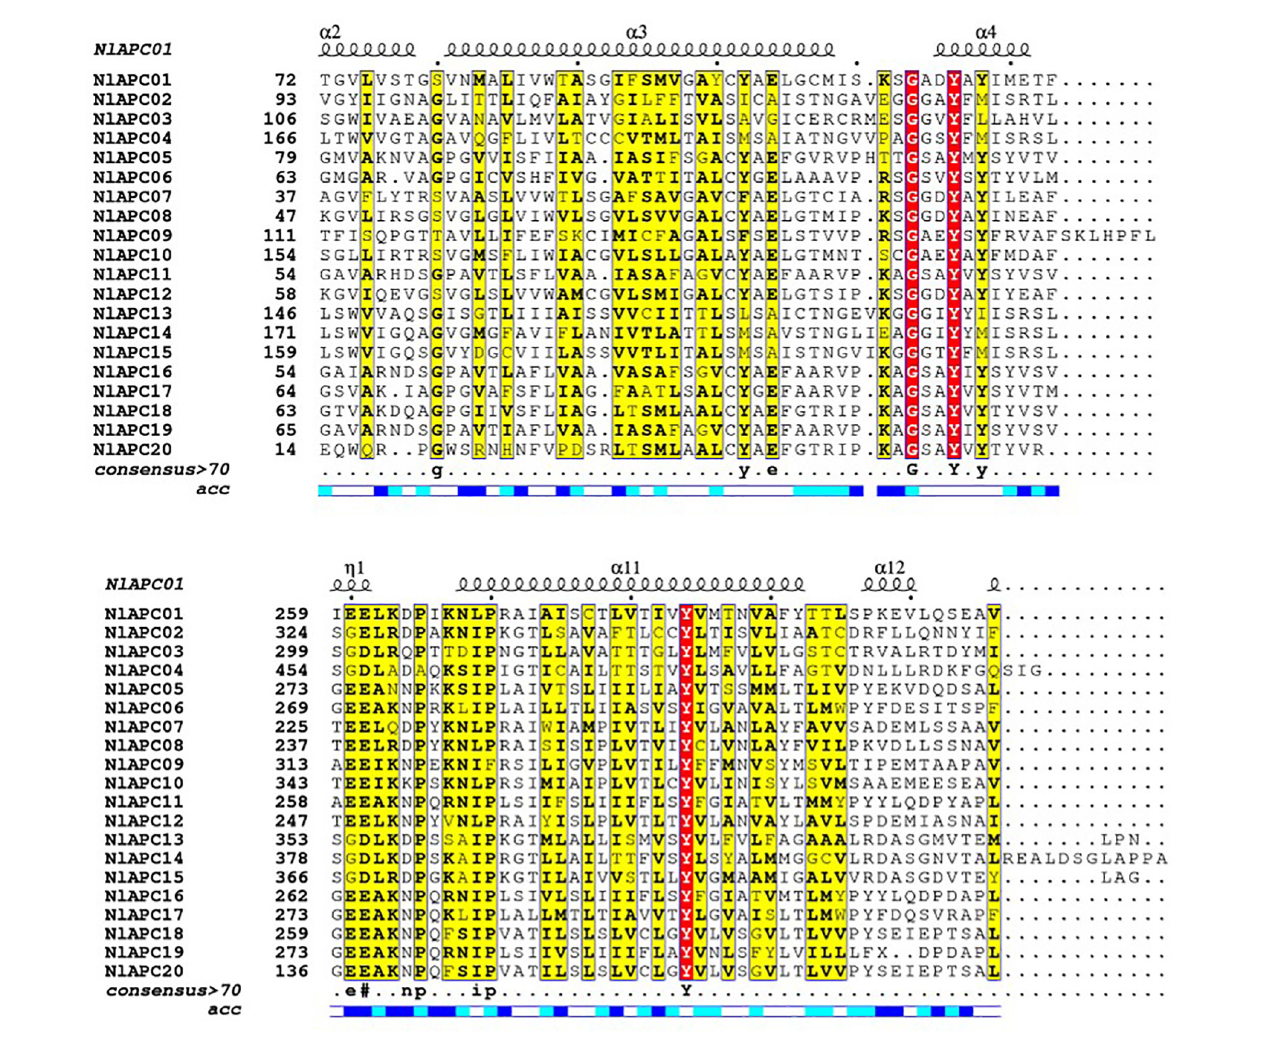
FIGURE 1 | Amino acid sequence alignment and the secondary protein structure prediction for APC transporters from BPH. Amino acid sequences of all 20 BPH APC genes were aligned by ClustalW v2.1 and were displayed using ESPript v3.0. Secondary structure elements prediction for each APC gene was performed on the SWISS-MODEL website (https://swissmodel.expasy.org/), and the results of NlAPC01 is shown above the alignment.